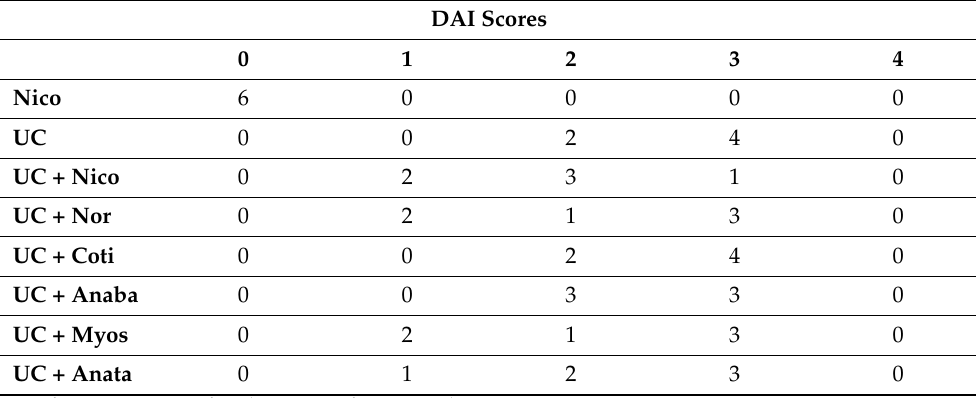
Table 2. Number of rats per each DAI score at Day 10.